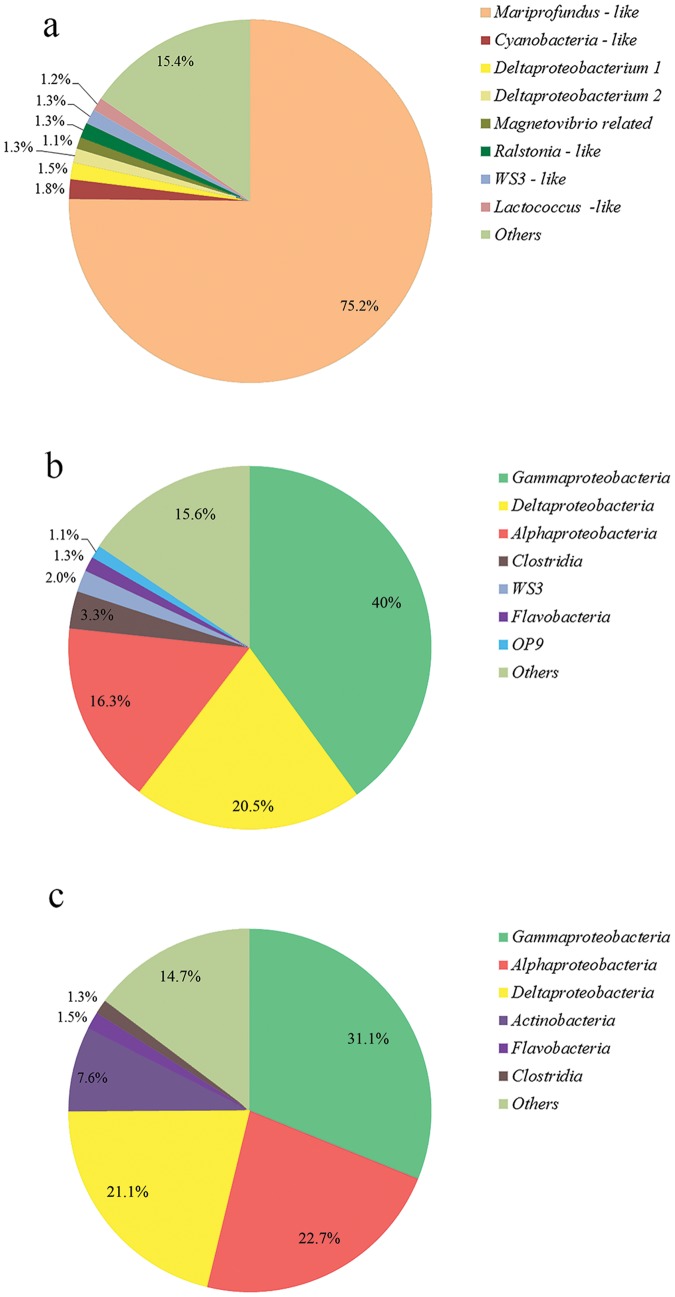
Relative abundance of major bacterial groups derived from bTEFAP analysis.a) Relative abundance of major microbial OTUs within the deposit collected from the 567 m Dor core. b) Relative abundance of major microbial classes within the 1 cm below the sediment-water interface section in the core taken from the deposit at the depth of 379 m in Dor disturbance. c) Relative abundance of major microbial classes within the 1 cm below the sediment-water interface section in the core taken from the non-deposit (control) sediment at the depth of 379 m in Dor disturbance.